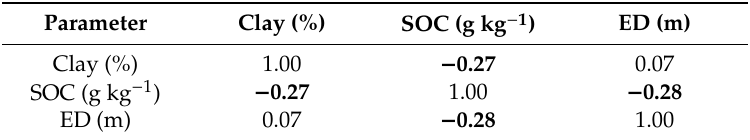
Table 2. Results of linear mixed effects model looking at the relation of microbial biomass carbon MBC to soil organic carbon (SOC), clay content, and elevation differential (ED).